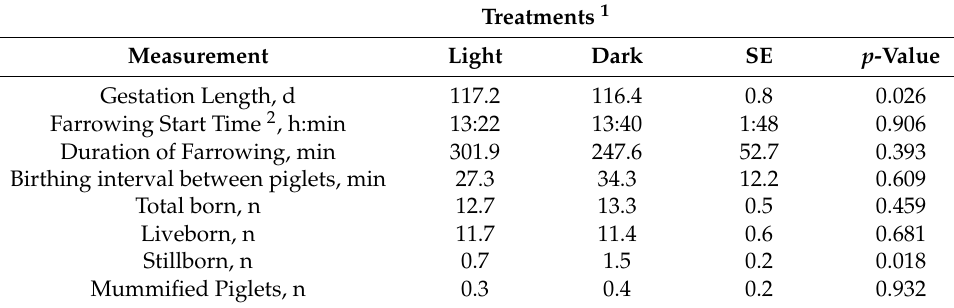
Table 3. Effect of light treatment on farrowing performance.